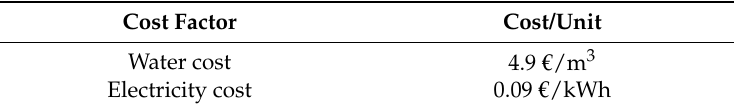
Table 3. Variable operational expenses.